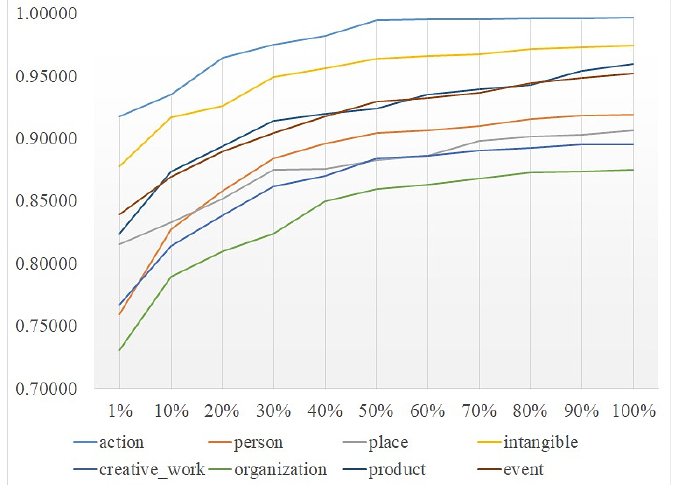
Figure 2. F1-measure increase along with the corpus size